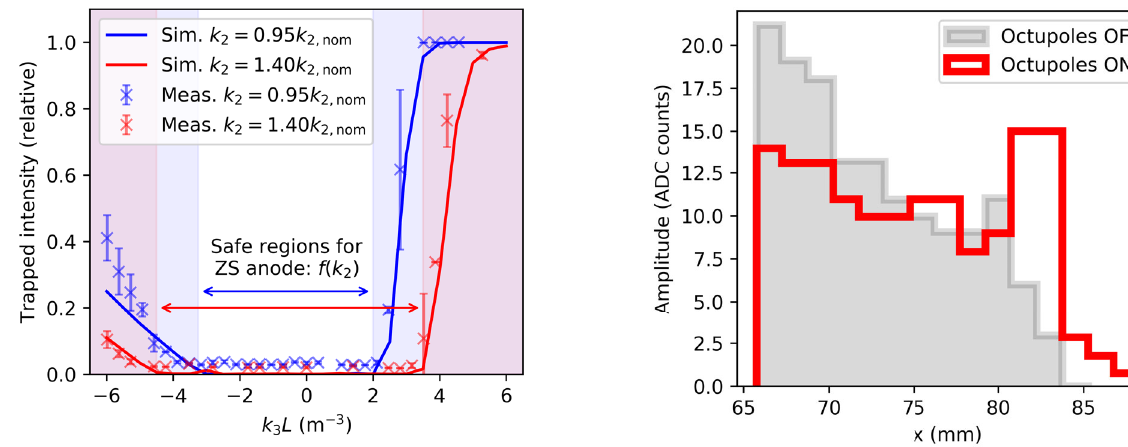
(a) Horizontal profile measurements of the extracted beam at BSGH.216, demonstrating an intensity reduction of 35% at the estimated position of the adjacent electrostatic septum blade ( x ZS 68 mm).